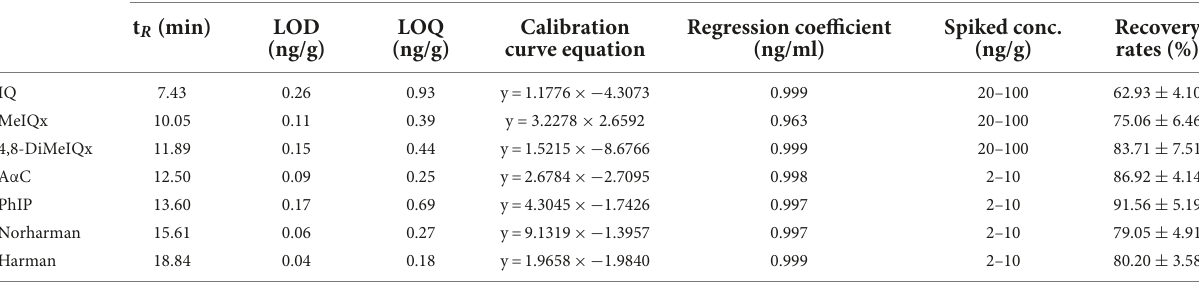
TABLE 1 Retention time, LOD, LOQ, calibration curve, regression coefficient, spiked concentration and recovery rates of different HCAs. HCAs ng/g meat sample t R (min) LOD LOQ Calibration Regression coefficient Spiked conc. Recovery (ng/g) (ng/g) curve equation (ng/ml) (ng/g) rates